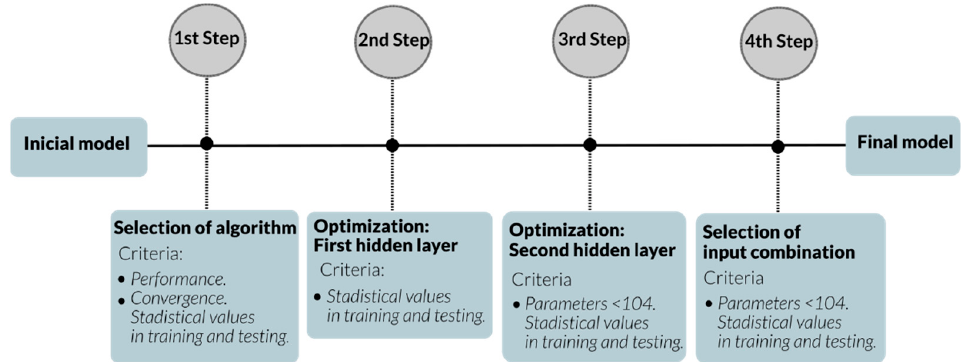
Figure 2. Schematic diagram of each step used in this study.